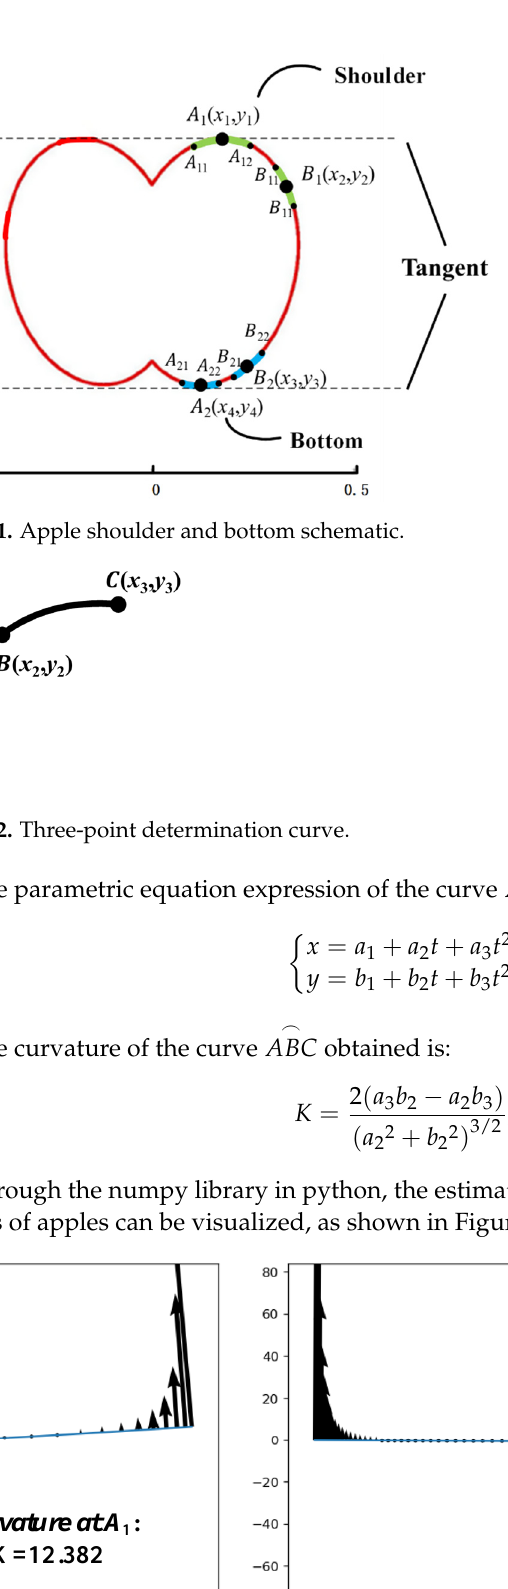
( b ) Figure 10. Apple conic fitting: ( a ) five representative points are selected on the front view of apple; ( b ) fit the apple conic of five points.